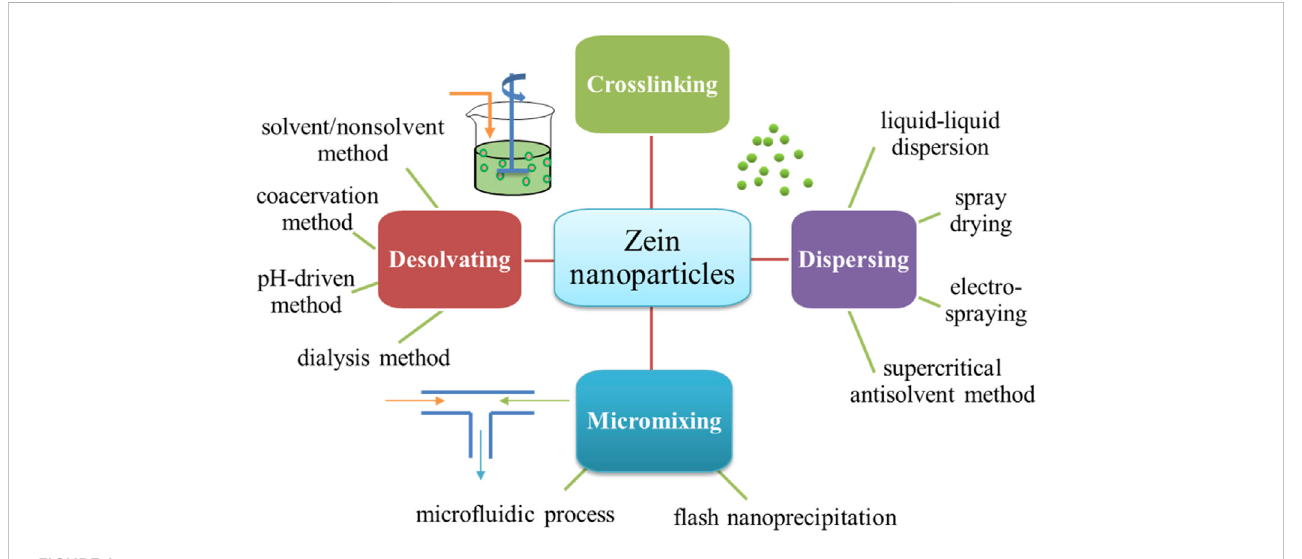
FIGURE 1 Preparation methods of zein-based